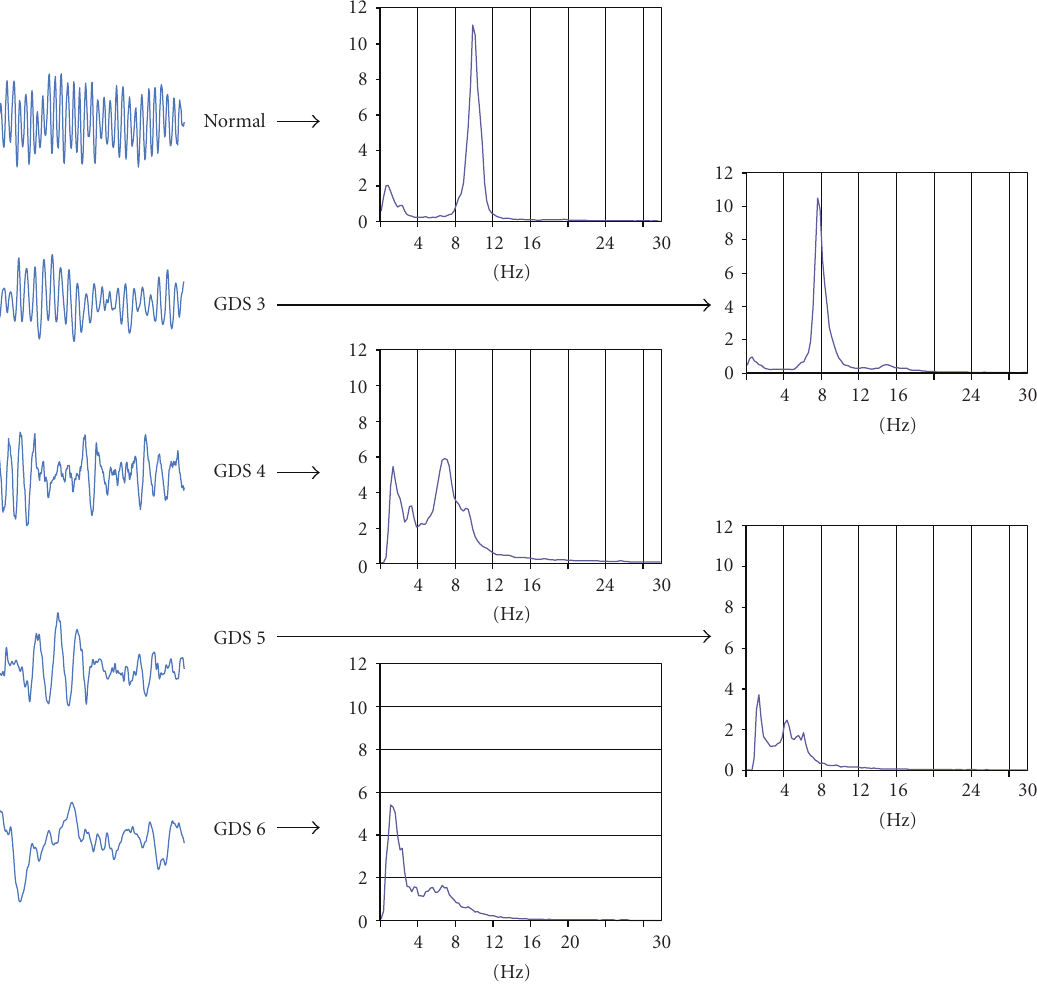
Figure 1: Sample of visual EEG and EEG spectrum on 4 clinical classes of severity (Global Deterioration Scale: GDS, from 3 to 6; for more details see text). EEG frequency bands ( X -axis) and percent value of each band ( Y -axis) are